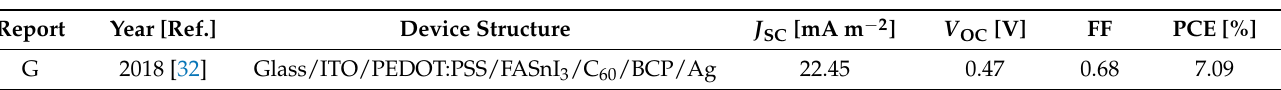
Table 4. Record table containing the reported Sn-PSCs and the corresponding photovoltaic parameters mentioned in Section 2.3. Report Year